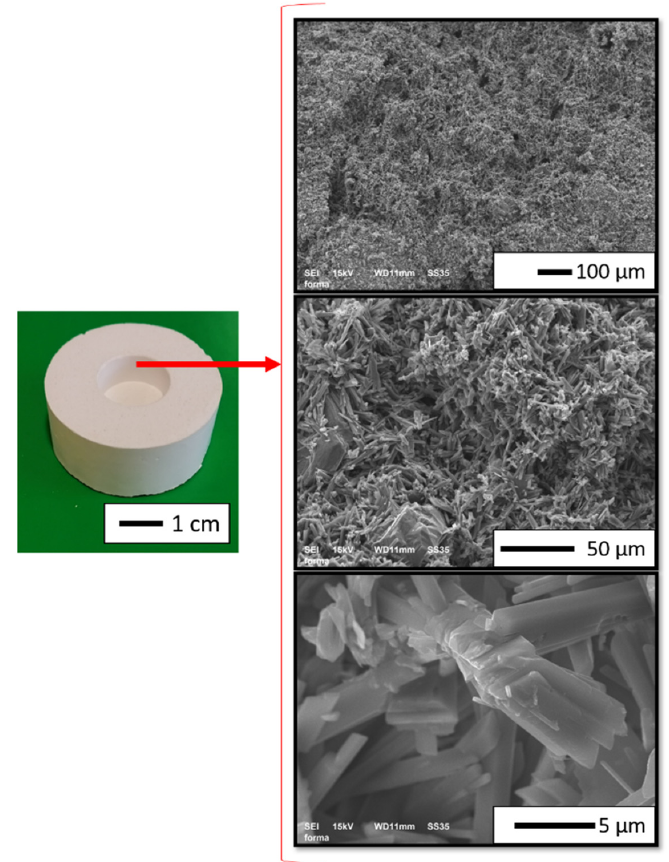
Figure 6. Macro and microstructure of the gypsum mold.